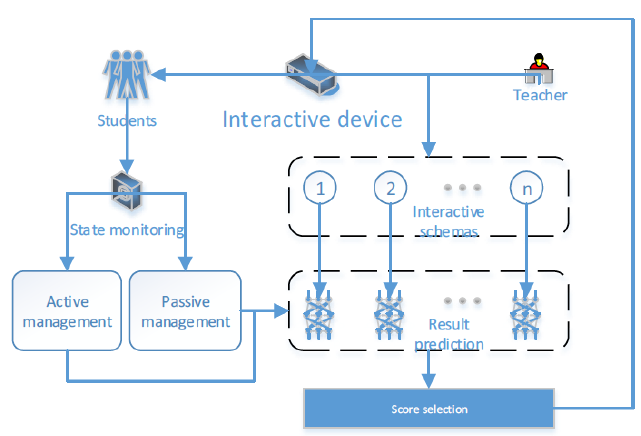
Fig. 3. The automated and intelligent management of interactive devices